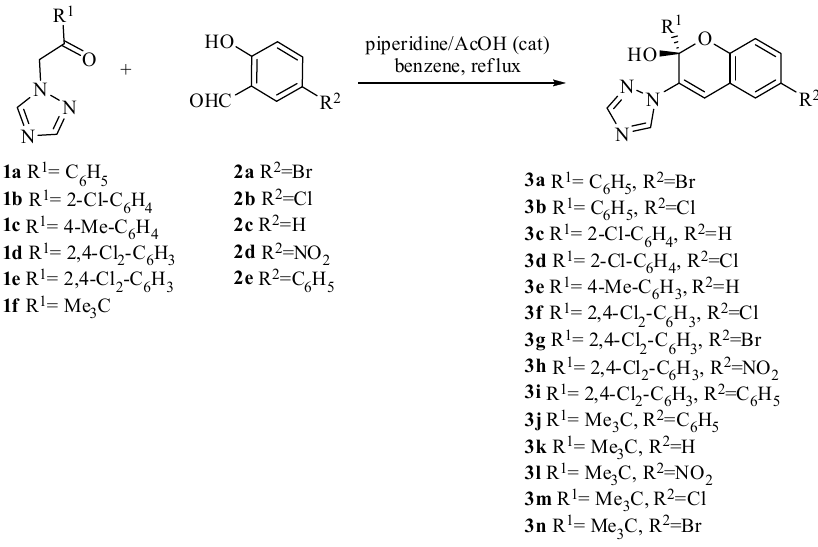
Figure 2. Structure of vinyl-1,2,4-triazole derivatives ( A ) and target chromene–triazole hybrid ( B ). Indeed, we performed the first synthesis of 1 H -1,2,4-triazole-functionalized chromenols via tandem reactions of 1-(alkyl/aryl)-2-(1 H -1,2,4-triazole-1-yl) with salicylic aldehydes (Figure 3).